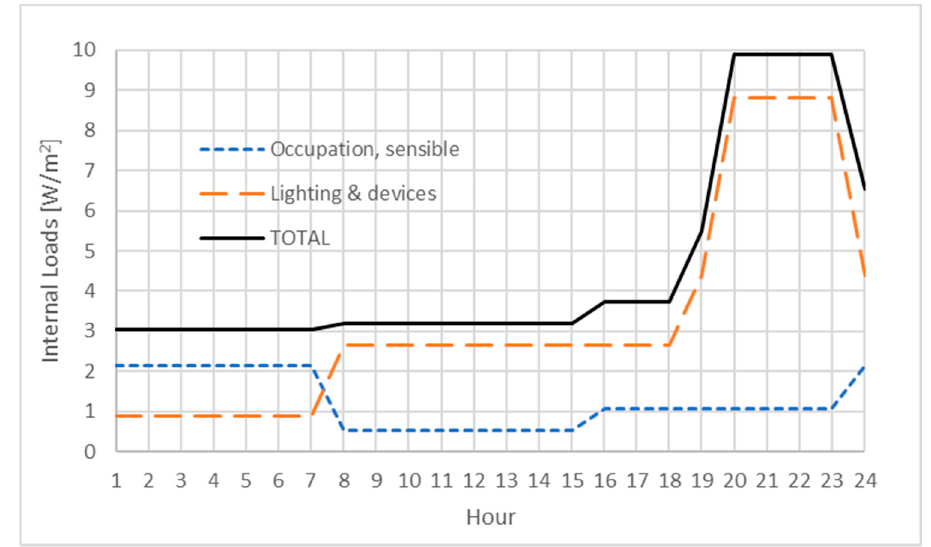
Figure 1. Internal loads level and their distribution at all hours of the day.